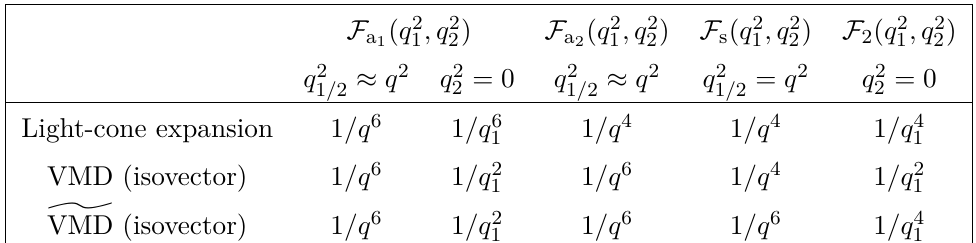
^ VMD are tailored to decrease as